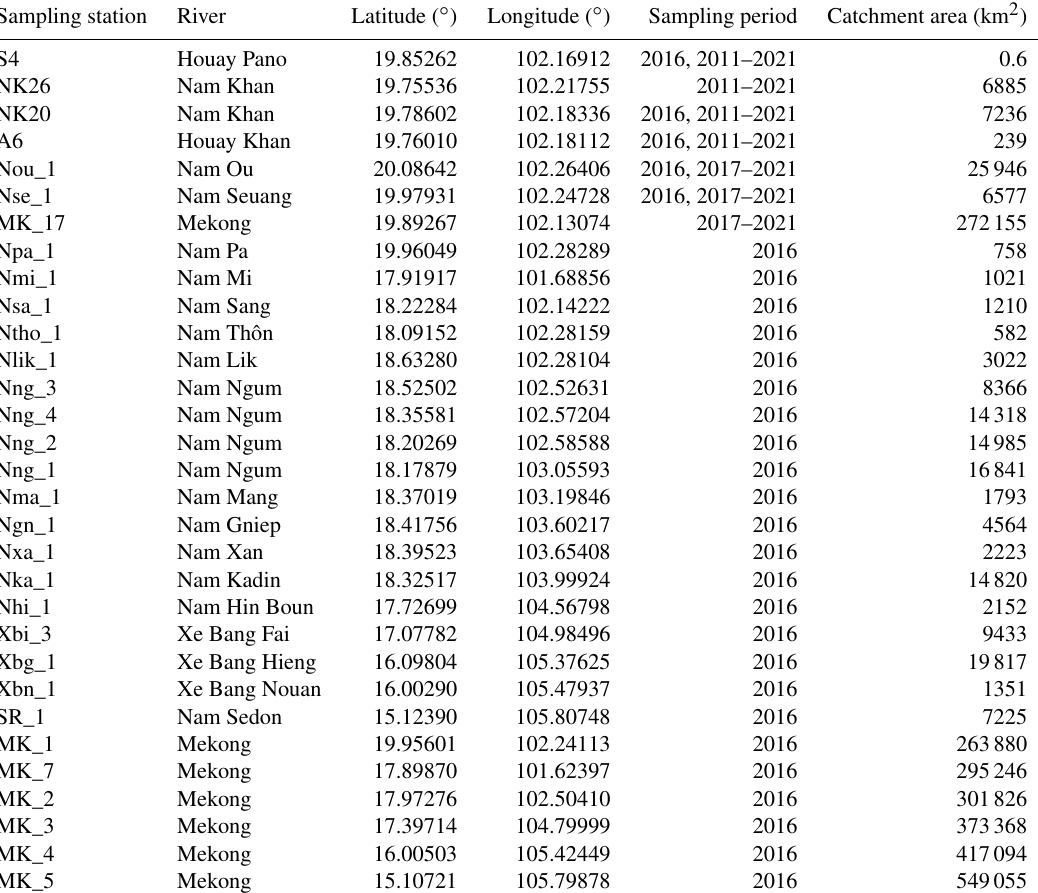
Table 1. Description of the 31 sampling stations within the Mekong River basin in Lao PDR: sampling station name, river name, geographical coordinates of sampling station (i.e., latitude and longitude in degrees, WGS 1984), sampling period, and catchment drainage area in km 2 .